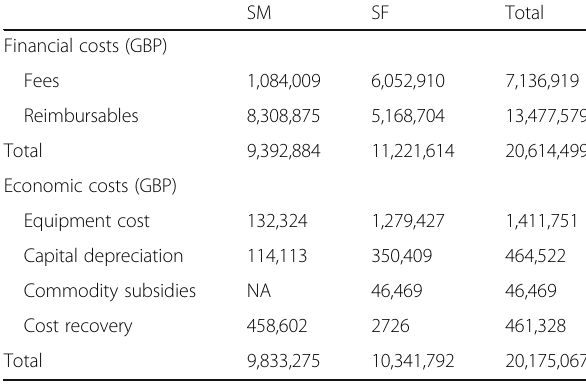
Table 1 Economic and financial costs of the DRHR